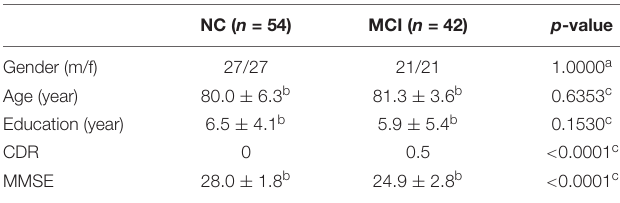
TABLE 1 | Demographic and neuropsychological information of the MCI and NC